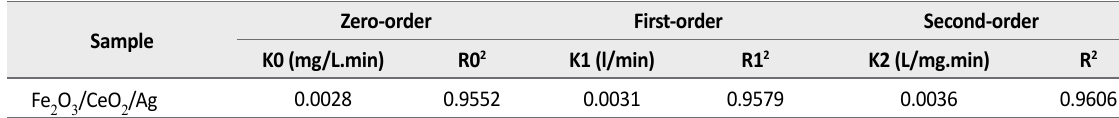
O /CeO /Ag sample 2 3 2